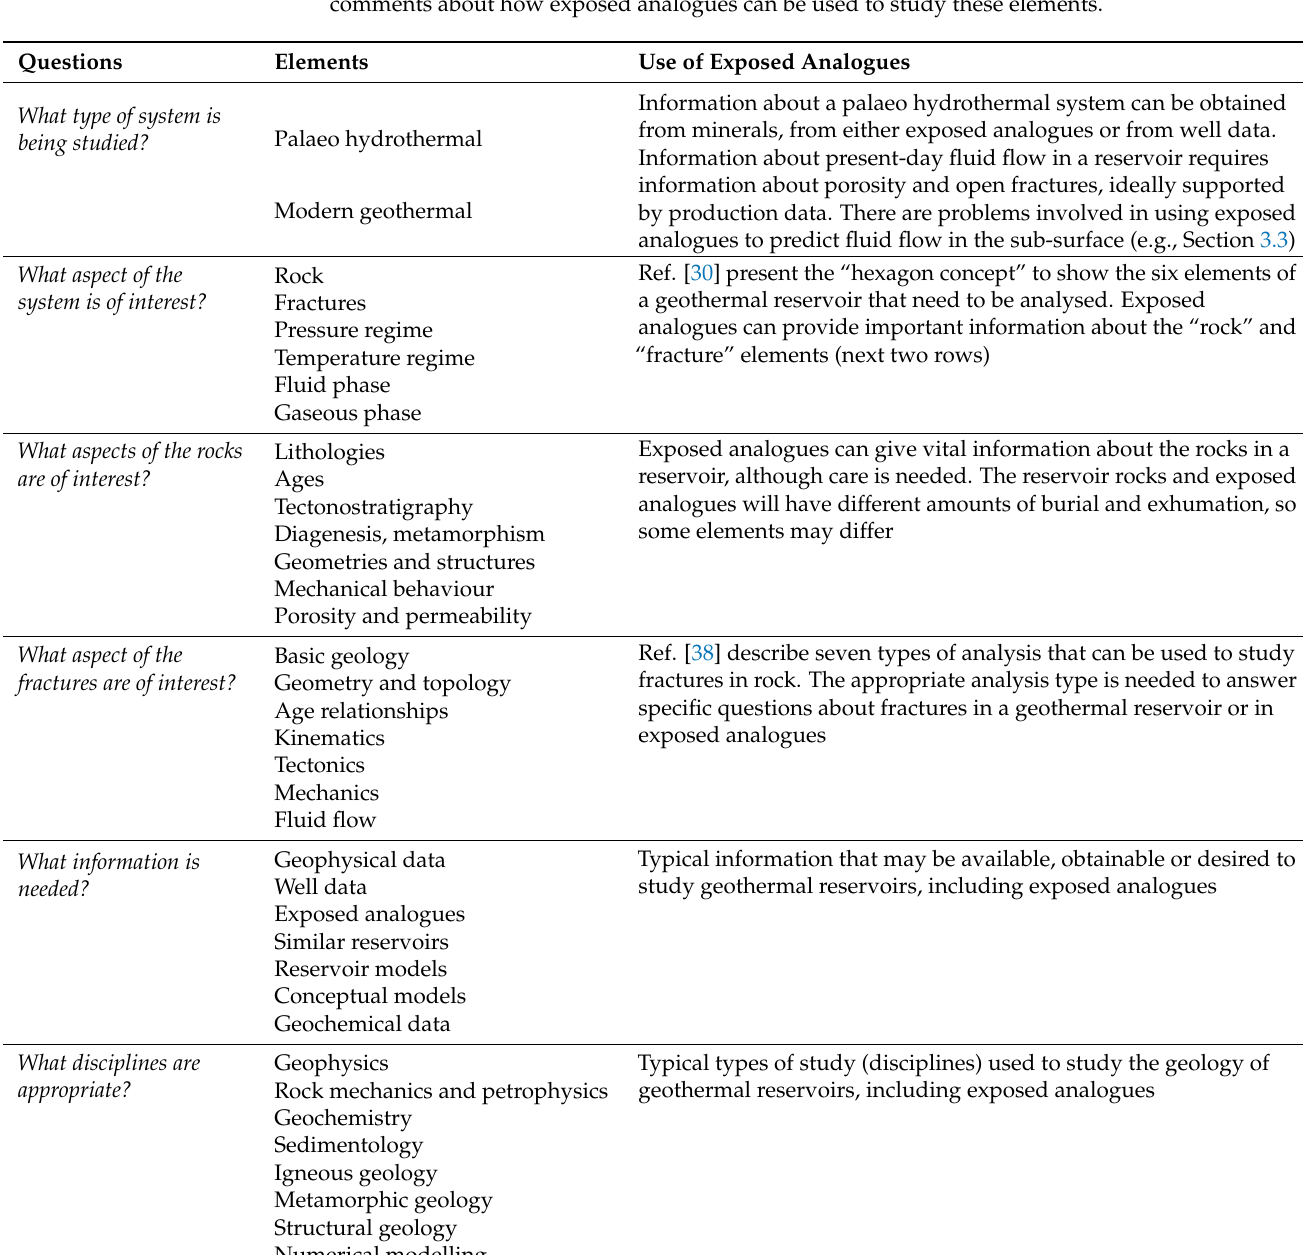
Table 2. Examples of questions that should be asked when planning a study of a geothermal reservoir or of an exposed analogue. Additionally, shown are typical elements that need to be considered and comments about how exposed analogues can be used to study these